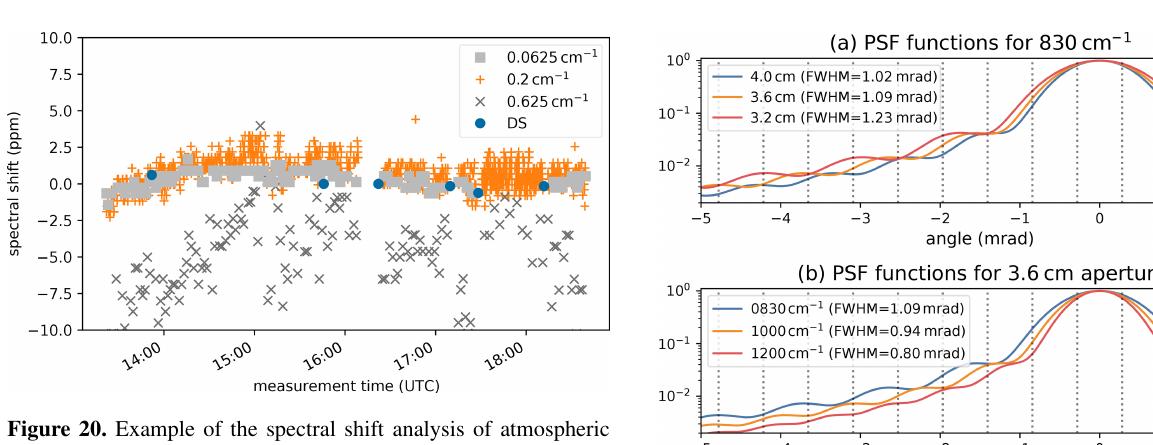
Figure 19. (a) Difference in calibrated radiance when measuring the same air mass at two different elevation angles and (b) the standard deviations thereof. The measurements were taken during the POLSTRACC campaign on 2 February 2016 at 22:00Z, alternating between − 0 . 38 and − 1 . 00 ◦ elevation.